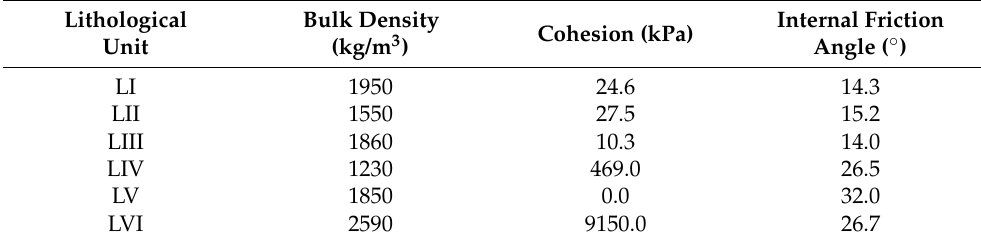
Table 6. Parameters of the lithological units assigned to calculate the slide plane for FoS = 0.70, located most closely to the observed slide